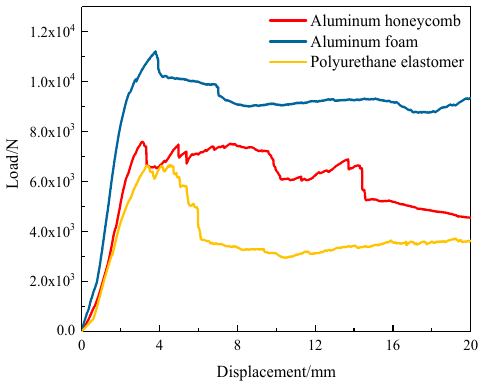
Figure 5. Load–displacement curves of the three composite sandwich laminated box beams.